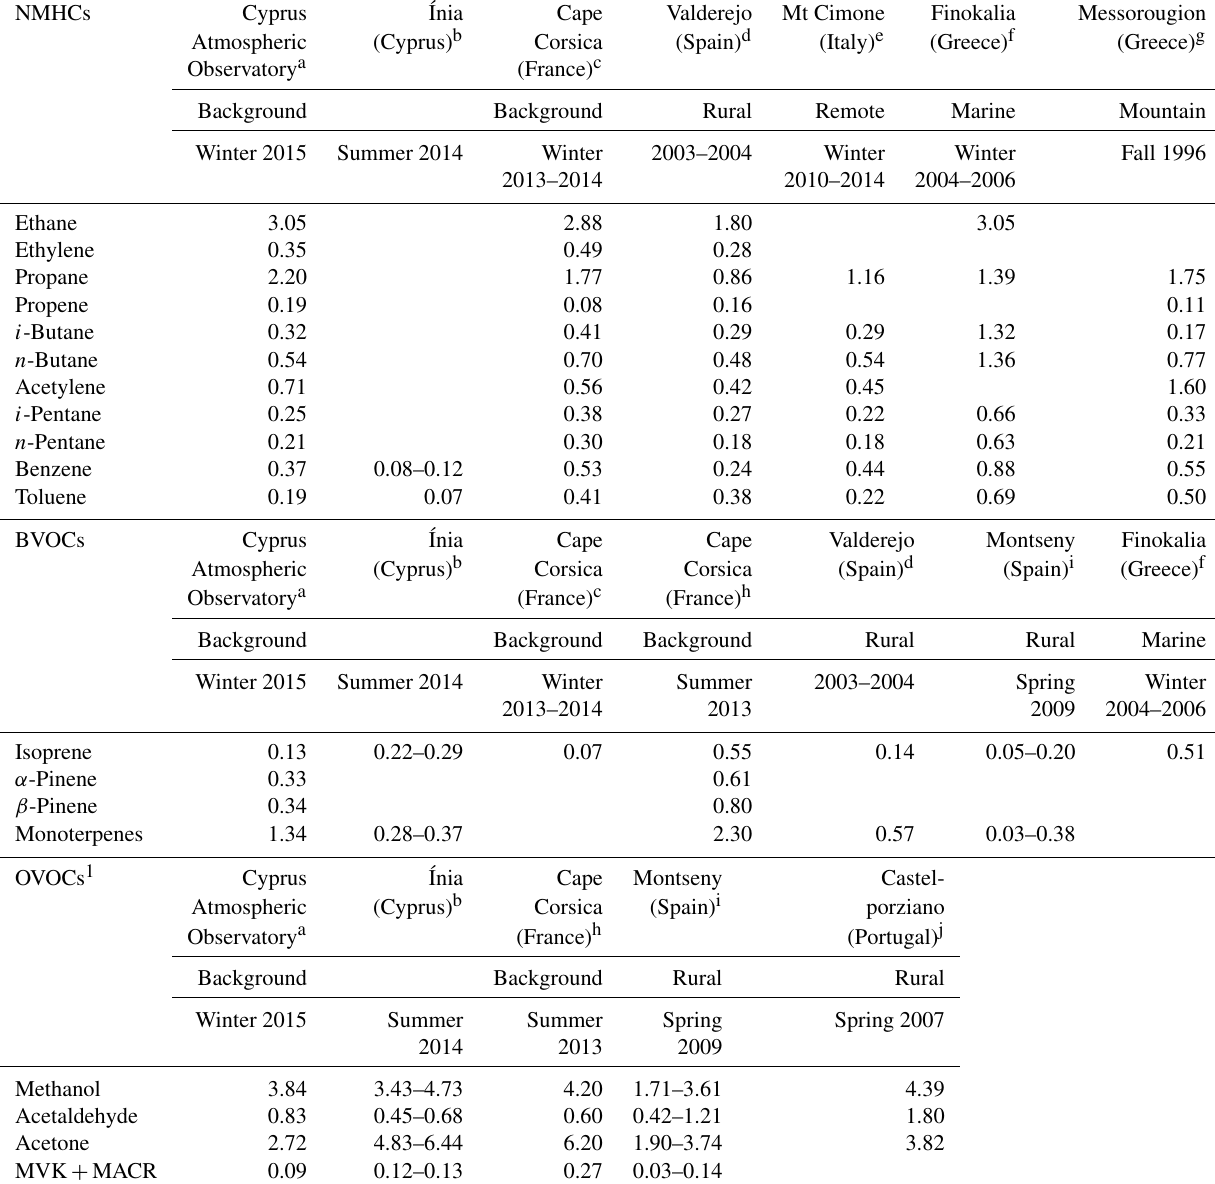
Table 3. Comparison of mean concentrations of selected VOCs with ambient levels observed in the literature in the Mediterranean region from different atmospheres. Concentrations are expressed in µgm − 3